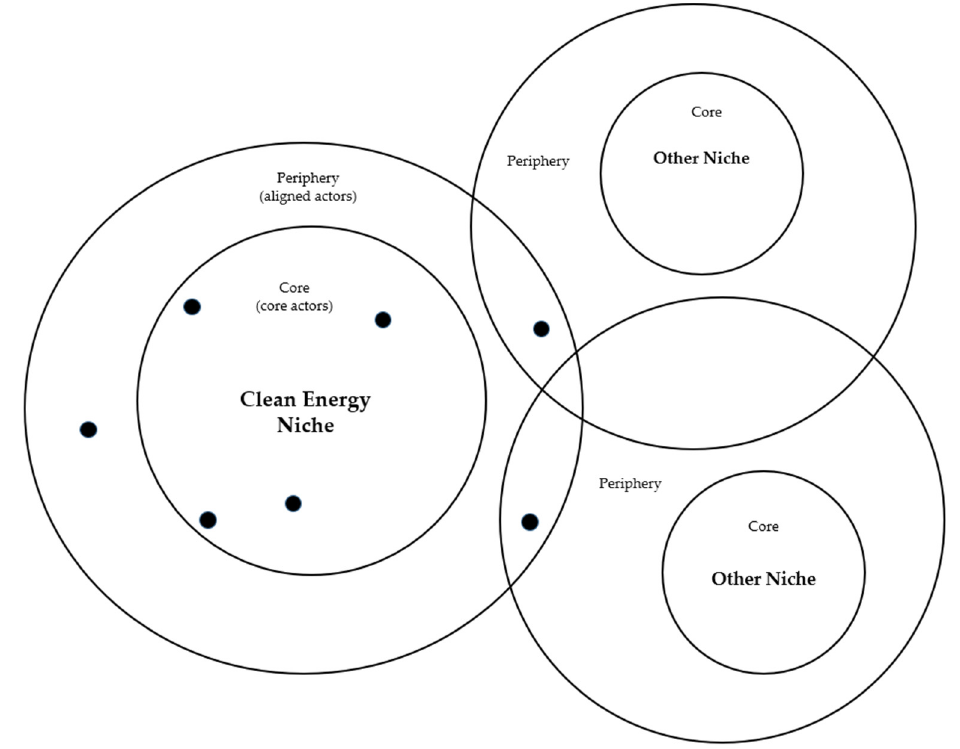
Figure 1. Core and peripheral actors. Source: Authors, based on Rosenbloom et al.